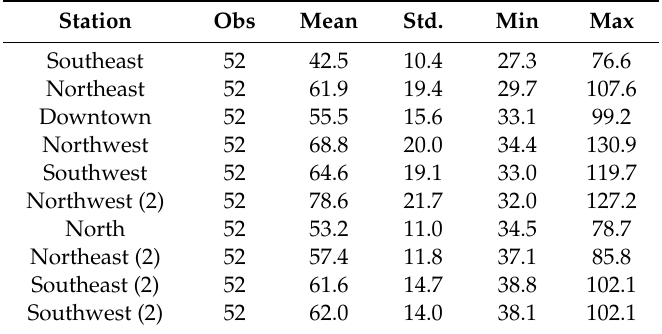
Table 2. Distribution of particulate matter (PM 10 ) concentration by monitoring station during